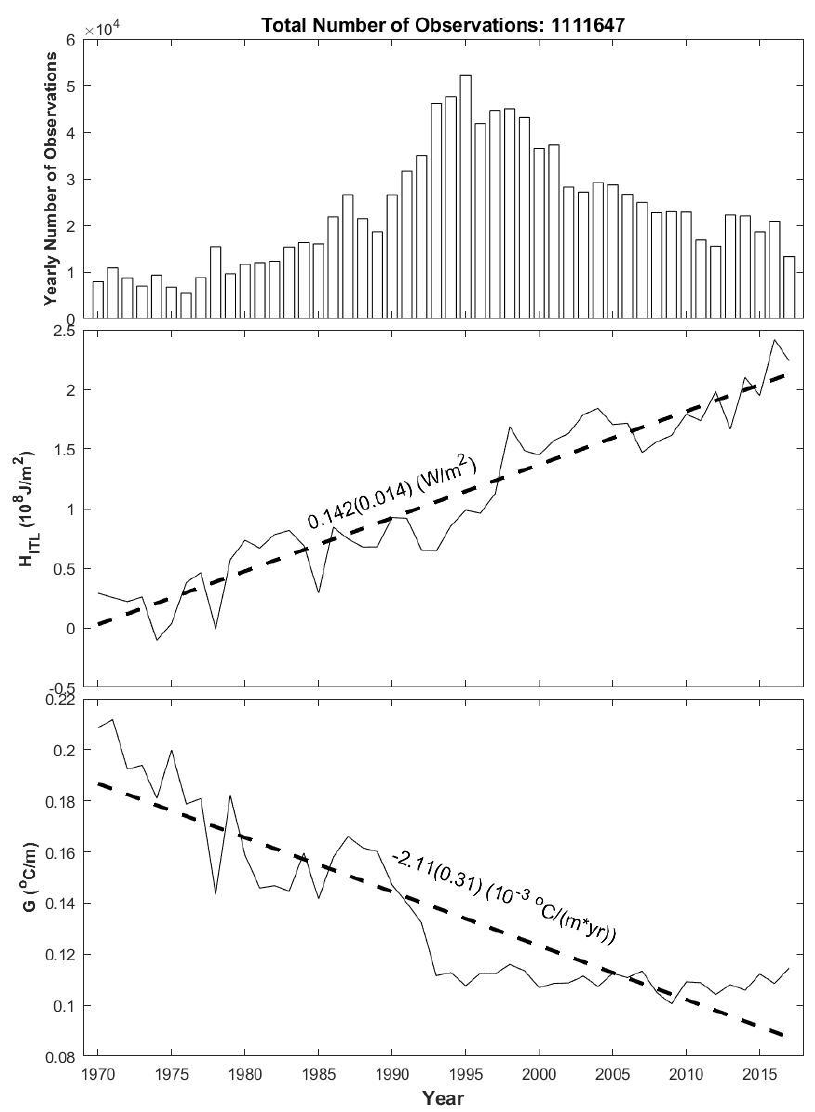
Figure 4. Yearly evolutions (1970–2017) of total number of observations (upper panel), relative heat content (unit: 10 8 J / m 2 ) (middle panel), and thermocline gradient (unit: ◦ C / m) (lower panel) for the world oceans excluding the Arctic Ocean. Note that the positive real number in the parentheses mean the half size of the confidence interval with the confidence level α =